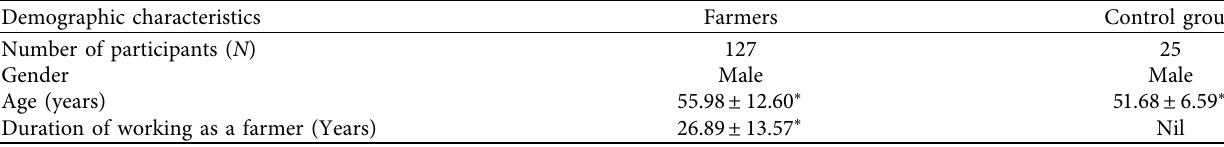
Table 3: Demographic characteristics of the control group and the participating farmers.